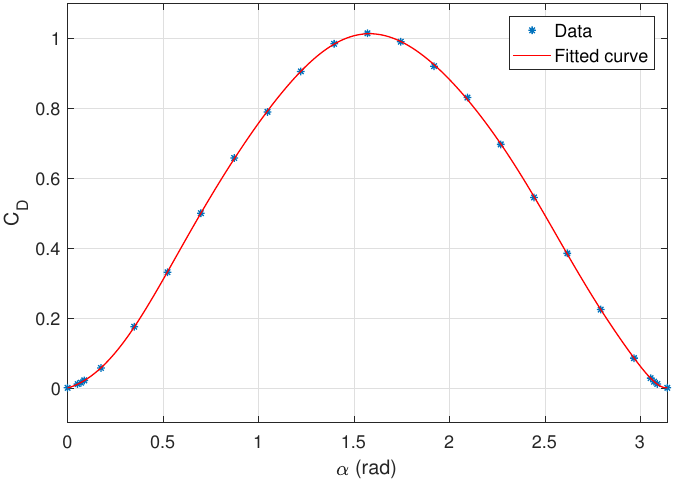
Figure 5. Drag coefficient of the rigid fin versus fin angle, α , obtained via numerical